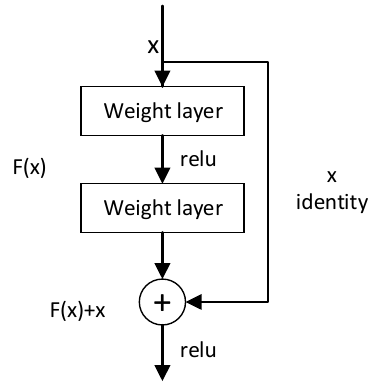
Figure 4. Deep residual learning block.